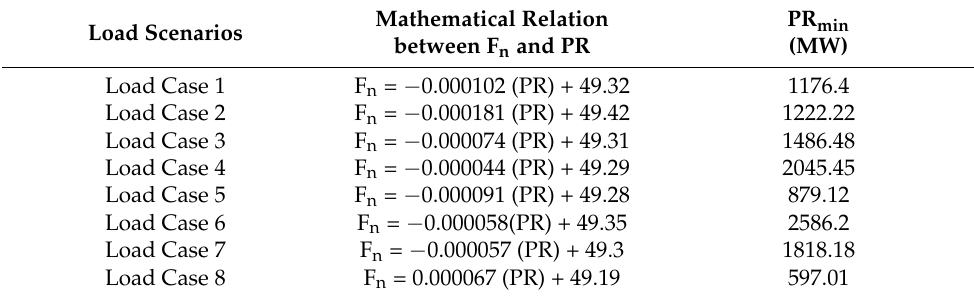
Table 4. Summary of calculated PR min values for various load scenarios.